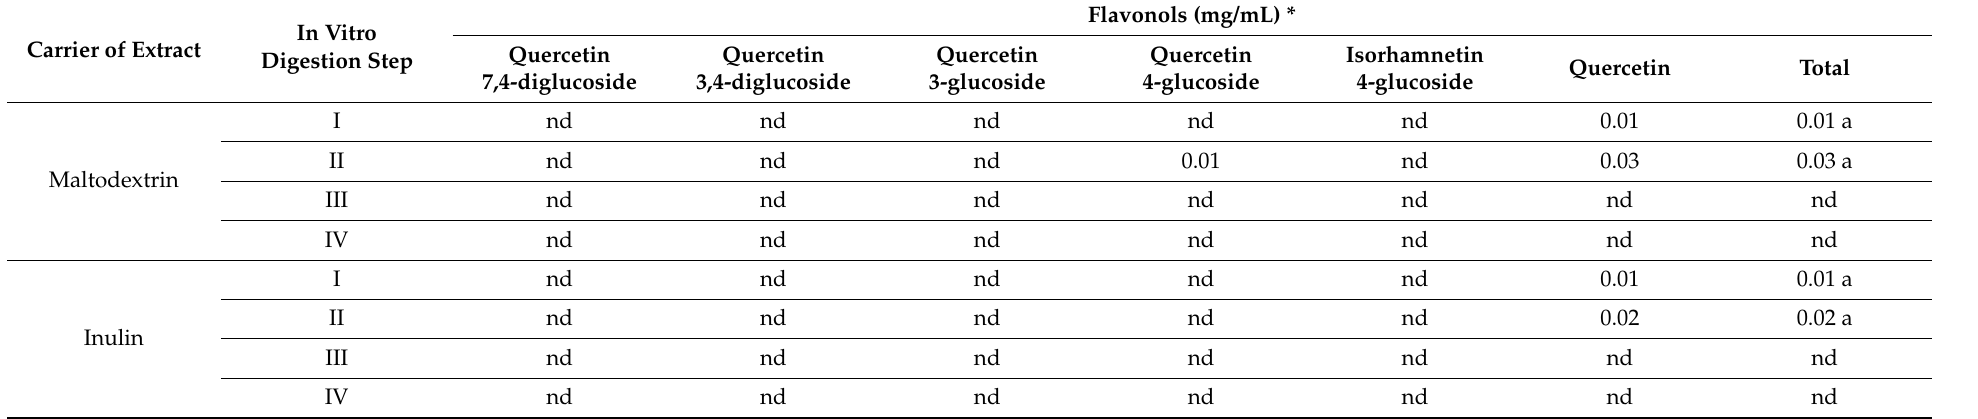
Table 3. Concentration on polyphenolic compounds (mg/mL) of liquids released during in vitro digestion of wheat bread enriched with onion extracts (OM, OI). In Carrier of Extract